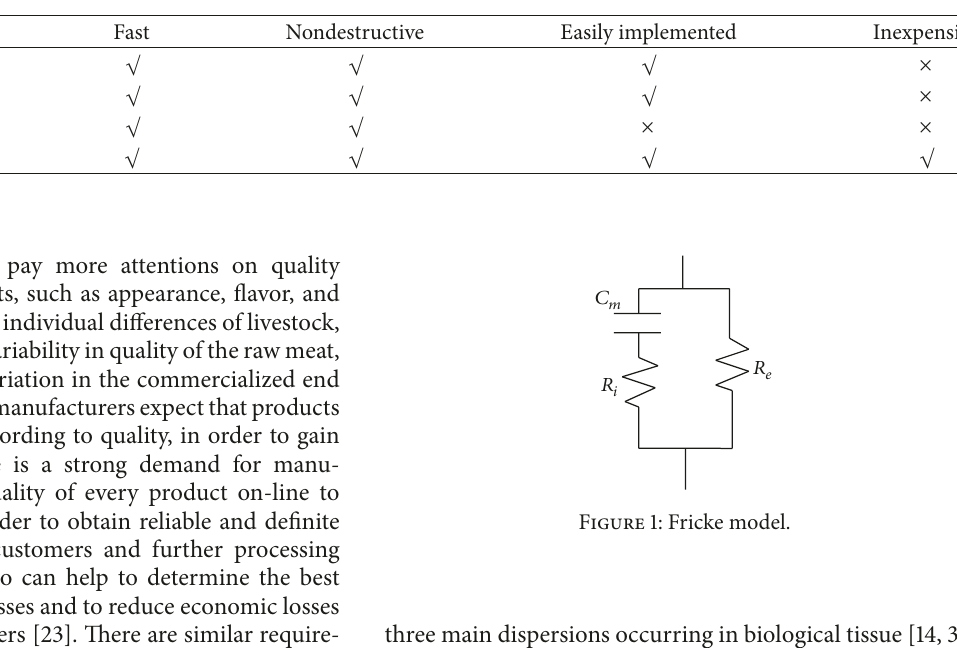
Table 1: Comparison of four new technologies.